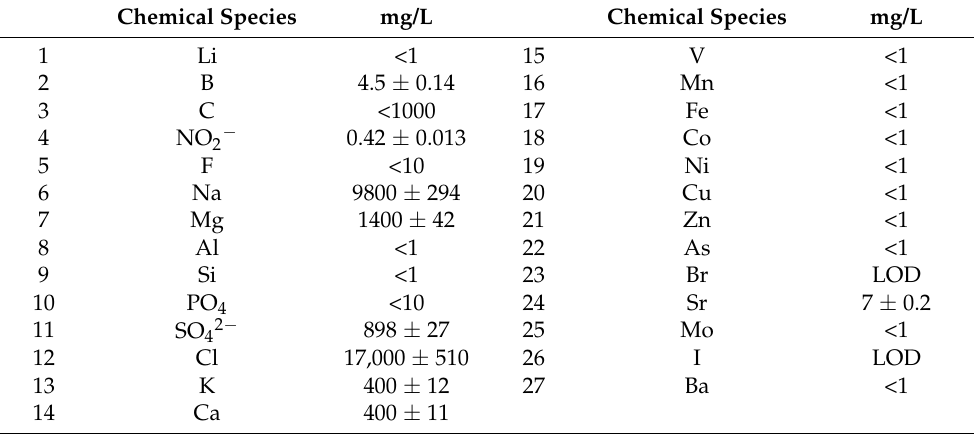
Table 1. Chemical composition of